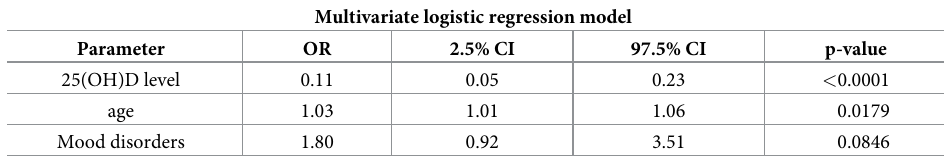
Table 4. Multivariate logistic model evaluating independent variables which influence